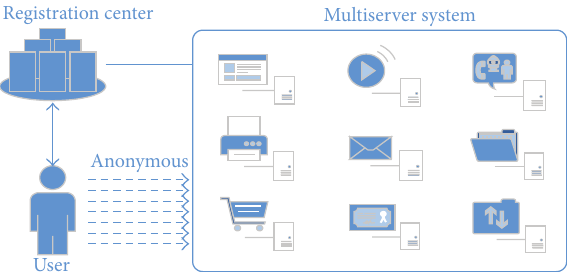
Figure 1: Framework of a multiserver authentication